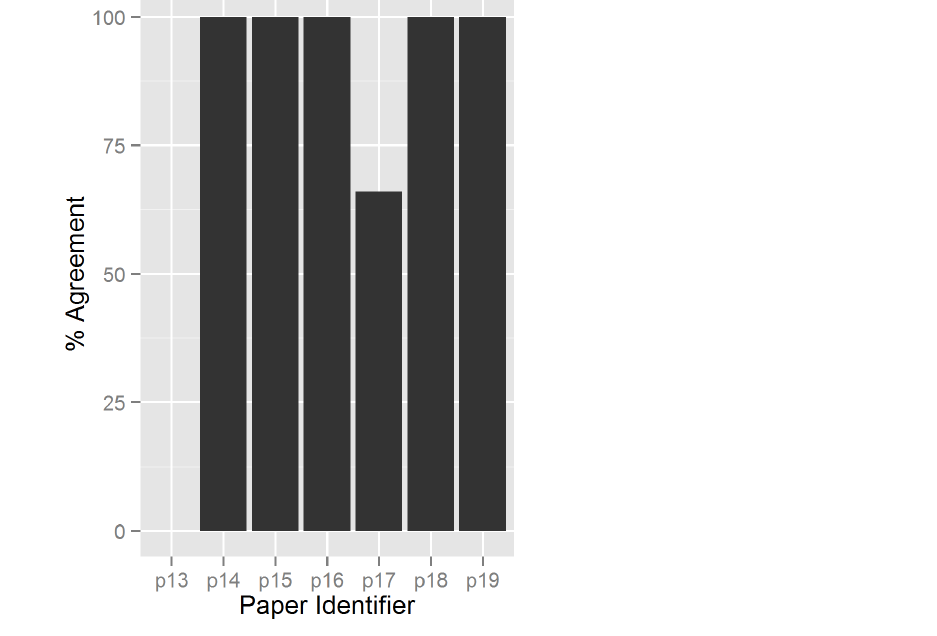
Fig. 1. Percent agreement between experts on final pass/fail result of papers tested in Round 3. Each paper was tested through the SOAR tool by 3–5 expert experts. Paper 13 had no agreement between the three experts due to misunderstanding of the data presented in the paper. Paper 17 had 1 of 3 experts